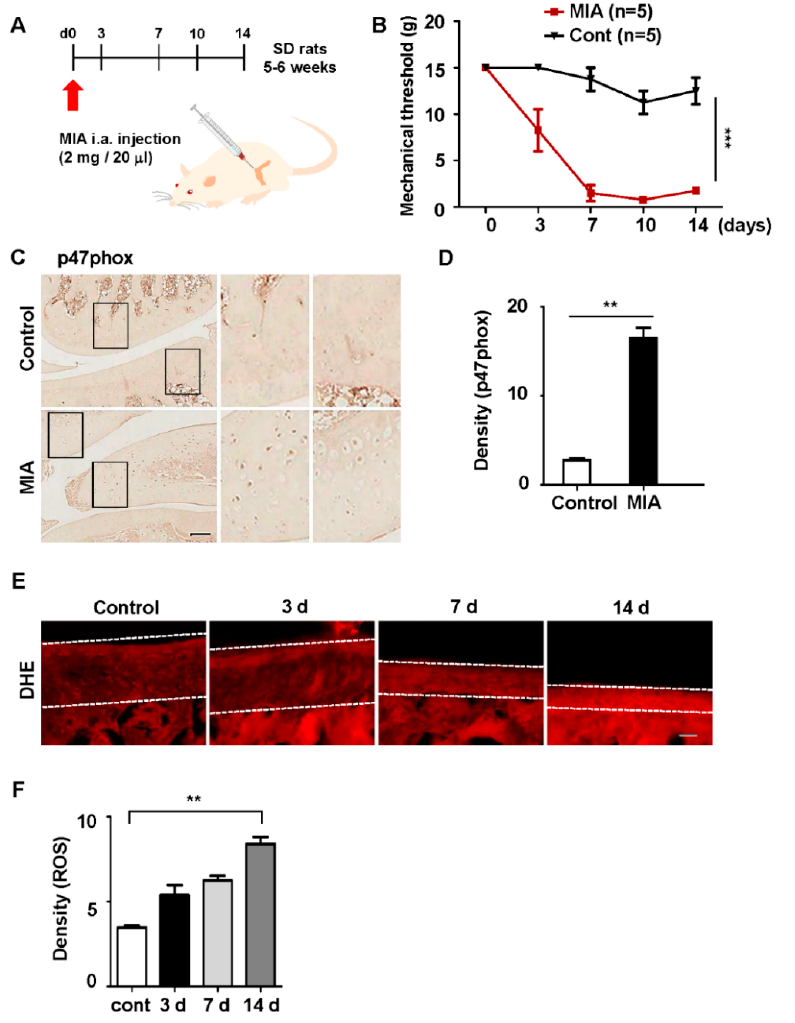
Figure 2. Monosodium iodoacetate (MIA)-induced expression of p47phox and the production of cellular ROS. ( A ) Prior to MIA injection, the rats were subjected to a von Frey filament test; only those that met a predefined threshold were selected for MIA injections. ( B ) The von Frey test was repeated on days 3, 7, 10, and 14 after injection; all data are presented as the mean ± standard error of the mean. ( C ) Rat knee tissues were immunostained with an anti-p47phox antibody at 3 days after MIA injection; scale bar = 50 µm. ( D ) The density of p47phox expression in the knee was measured by using ImageJ software; all data are presented as the mean ± standard error of the mean. ( E ) DHE fluorescence imaging of the knee in the OA rat model; white lines indicate cartilage in the tissue. ( F ) Quantification of DHE fluorescence; all data represent the mean ± standard error of the mean (error bars) of three experiments.